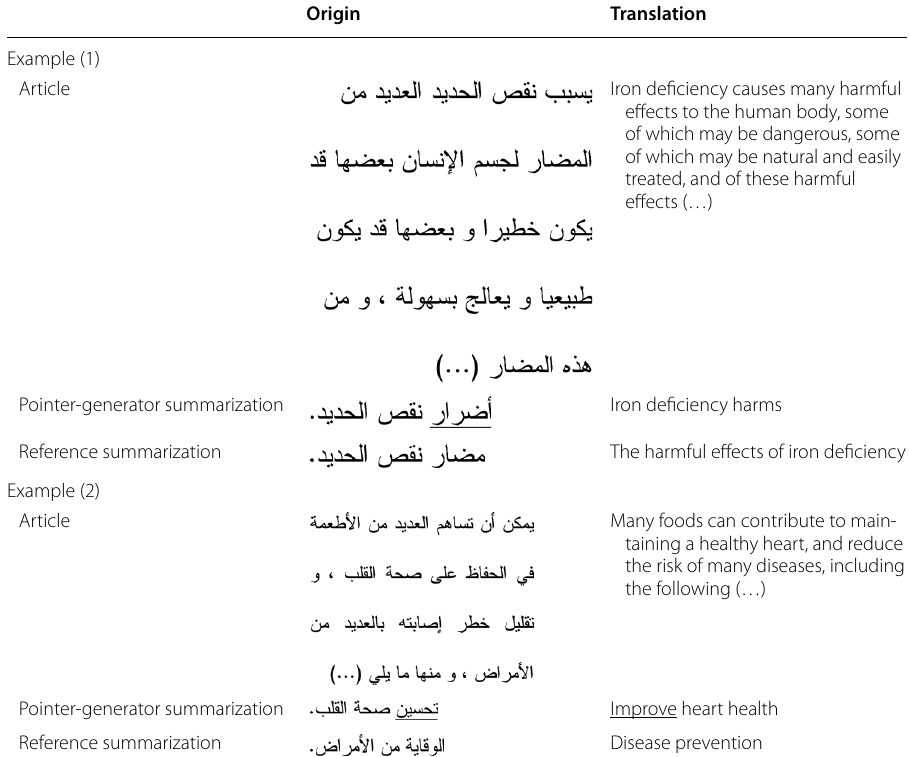
Table 4 Two examples of headline generation by the pointer-generator model with